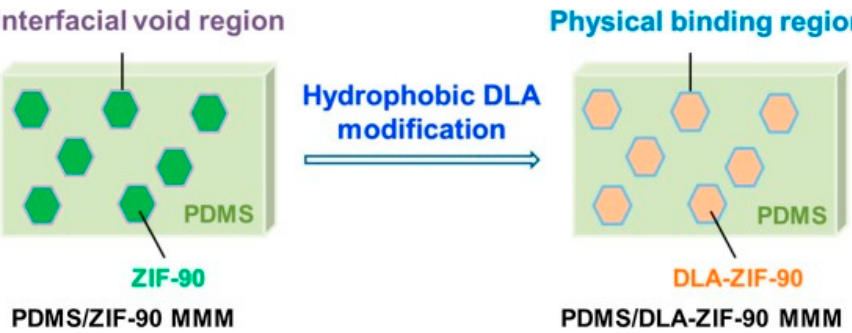
Figure 8. Schematic of physical binding between DLA-ZIF-90 particles and the PDMS matrix.